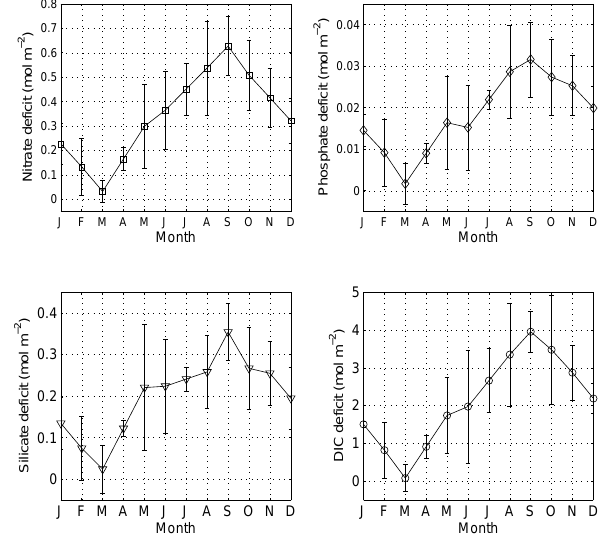
Figure 4. Calculated monthly-mean deficits of nitrate, phosphate, silicate, and carbon, in the upper 100m in the Iceland Sea. For the calculations we used mean monthly values for the 100–200m depth range as reference. The error bars show the propagated error (un- certainty) from the standard deviation of the respective reference concentrations and the average monthly standard deviation in the surface layer. As for the MLD calculations, for the months sampled less than three times in the time series we have used interpolated values. See text for